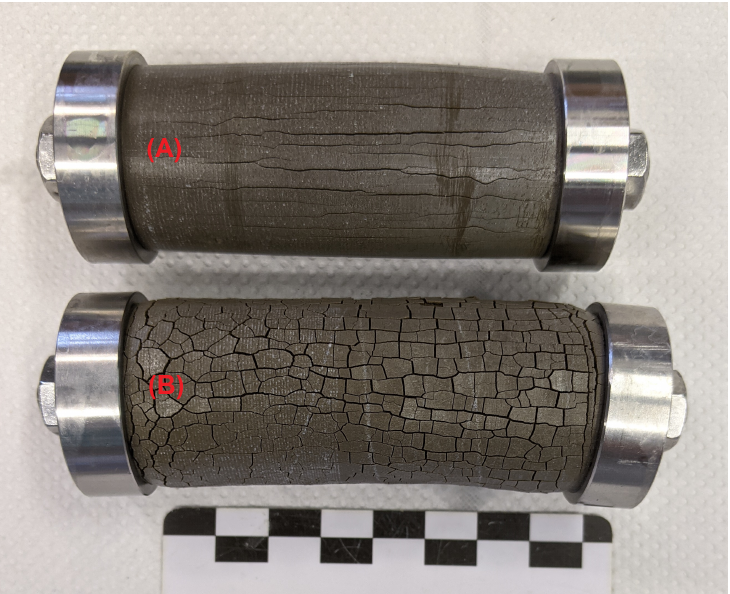
Figure 4. Characteristic crack patterns of hollow cylinder samples after storage in sodium sulphate solution: ( A ) stress cell with additional constraint by a central steel rod: major cracks are formed among the longitudinal axis; ( B ) stress cell with virtually no additional constraint by using a steel spring with a low spring constant, where a network pattern of cracks is formed due to equal elongation of the sample in every spatial direction.